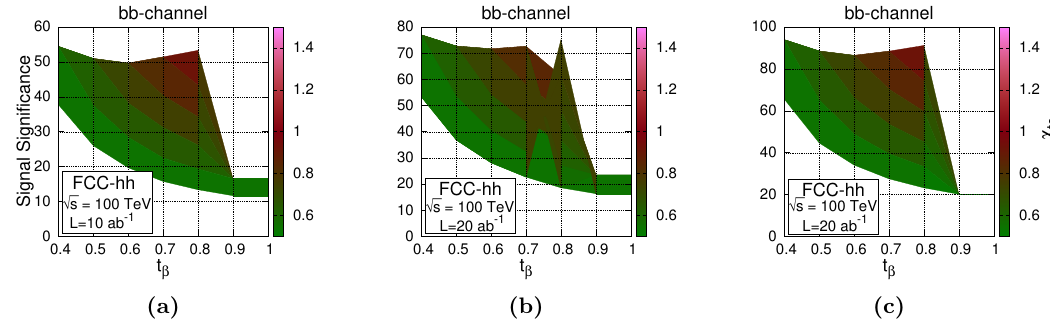
Figure 12. The same as in (cid:12)gure 10 but for: (a) L =10 ab (cid:0) 1 , (b) L =20 ab (cid:0) 1 , (c) L =30 ab (cid:0) 1 . The case (c) represents the (cid:12)nal integrated luminosity reached by the